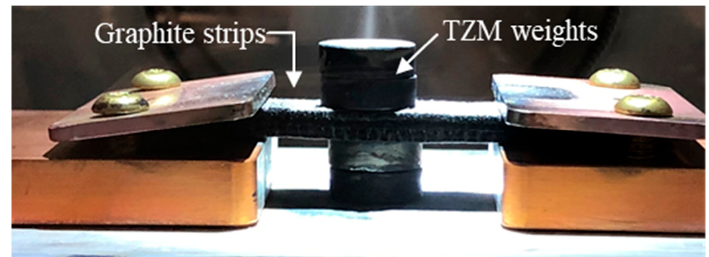
Figure 2. Heating stage configuration. The sample is placed in between the graphite foam strips and pressed by the TZM weights to improve the contact and heat conduction.